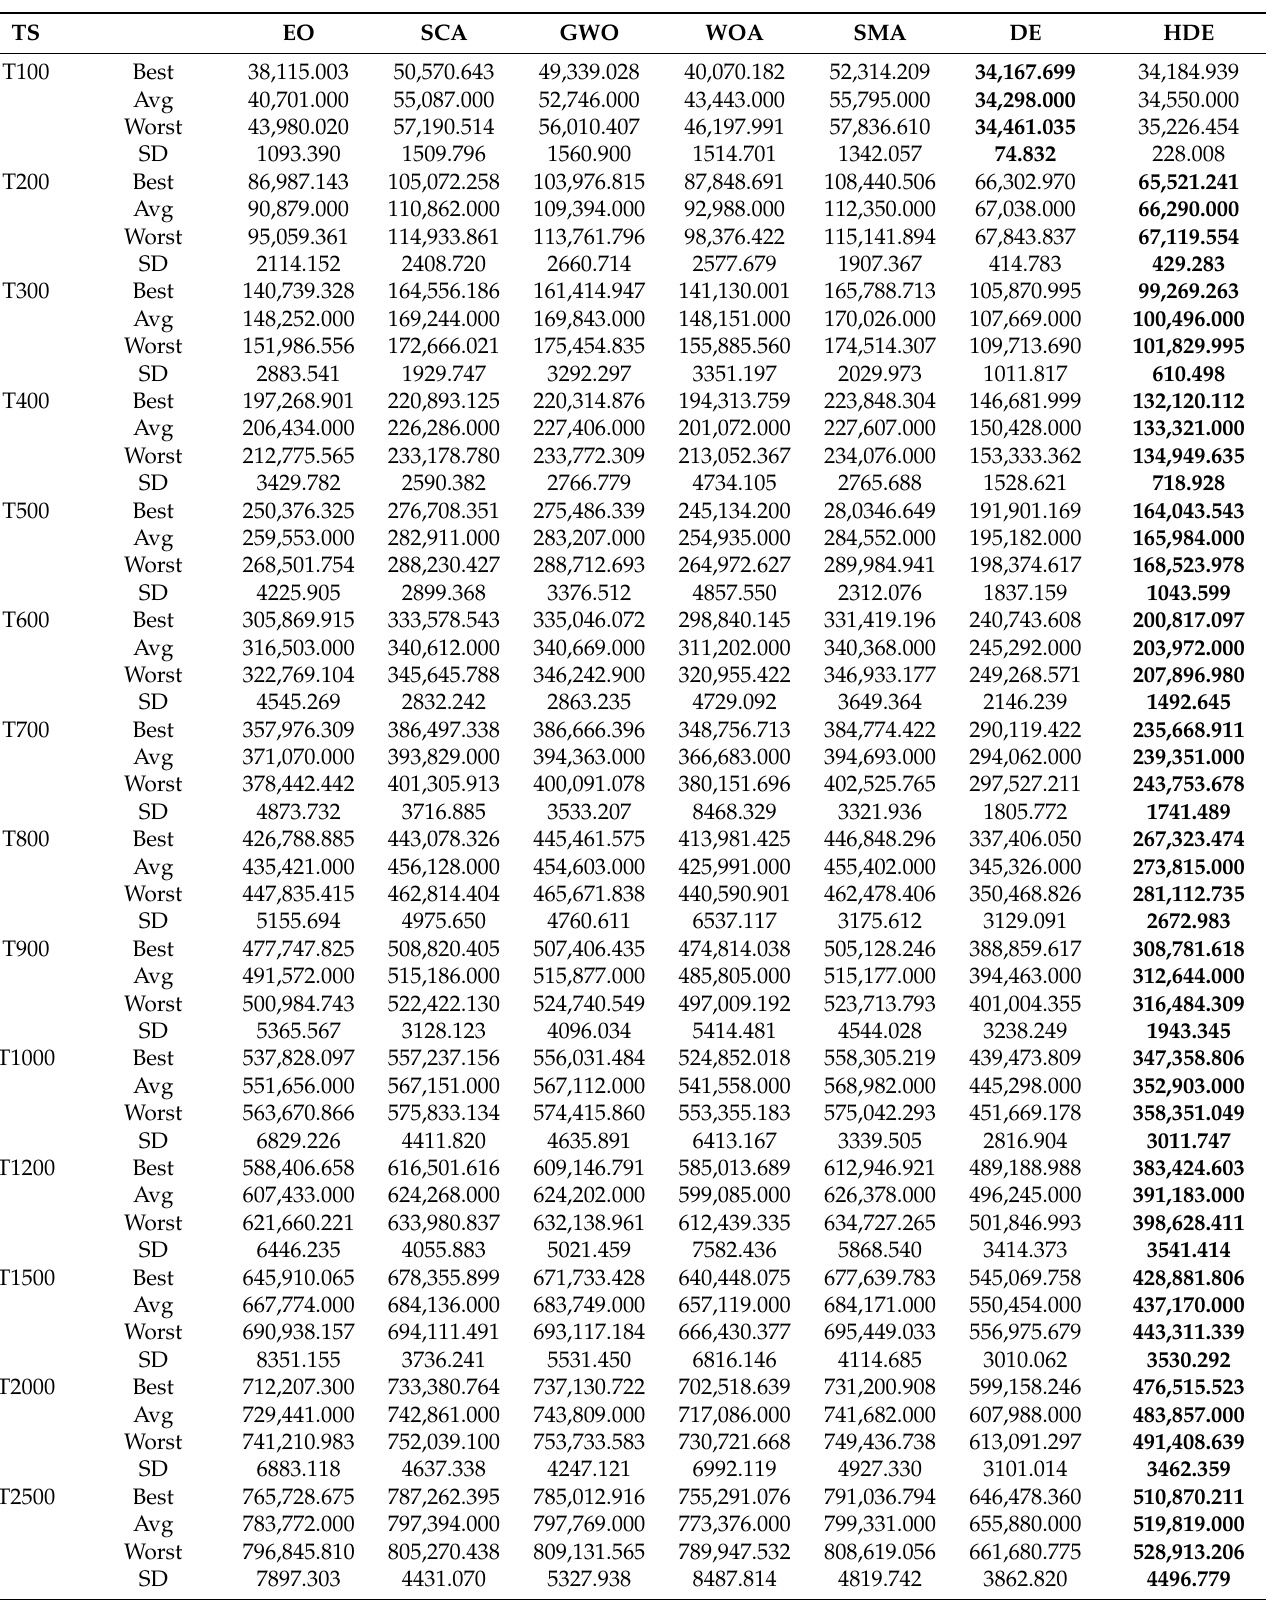
Table A3. Comparison among algorithms for total execution